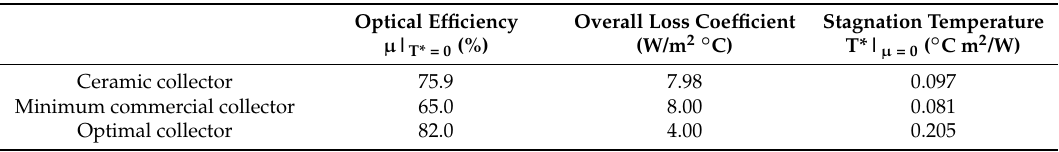
Table 2. Values of the optical efficiency, global coefficient of losses, and stagnation. Temperatures of the ceramic collector and commercial collectors